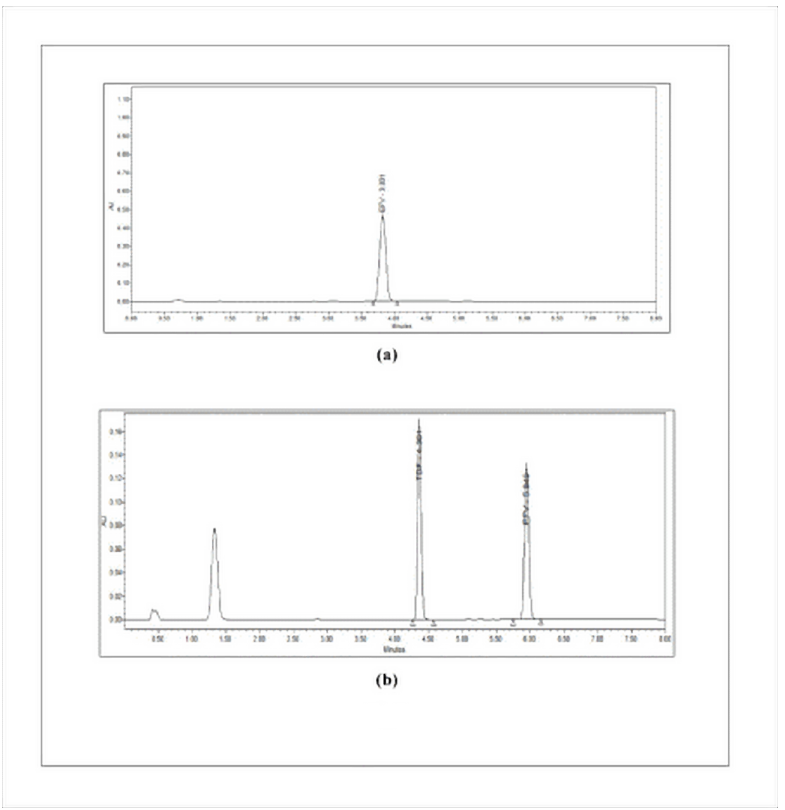
Fig 2. Representative chromatographic peaks obtained during analytical method development.